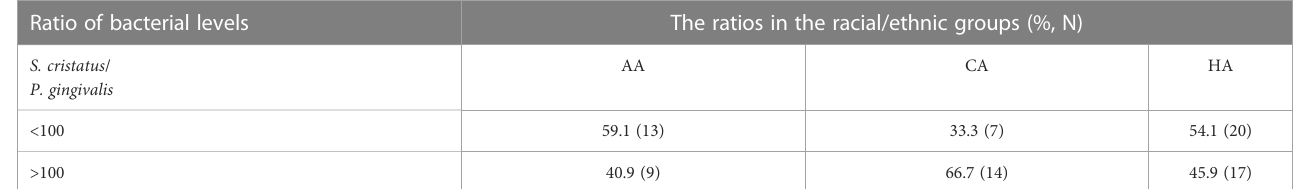
TABLE 8 Correlation between P. gingivalis and S. cristatus in P. gingivalis -positive participants. Ratio of bacterial levels The ratios in the racial/ethnic groups (%,